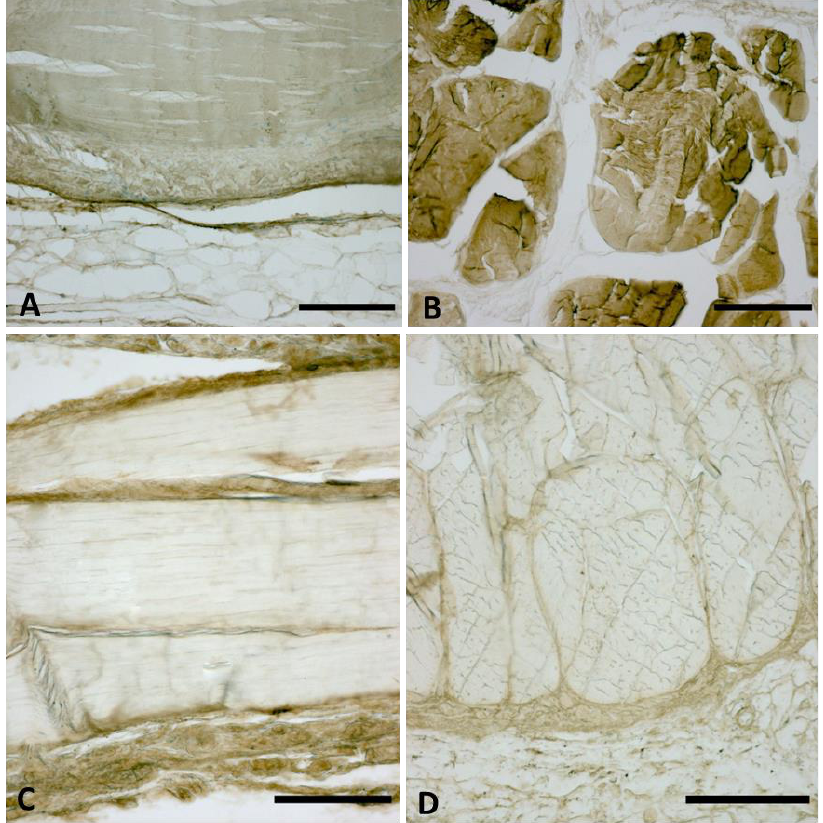
Figure 3. Immunocytochemistry to detect collagen type I ( A , B ) and collagen type III ( C , D ) , in longitudinal ( A , C ) and transversal ( B , D ) directions. Scale Bars: 200 µm. Magnification: ( A – D ) = 10×.